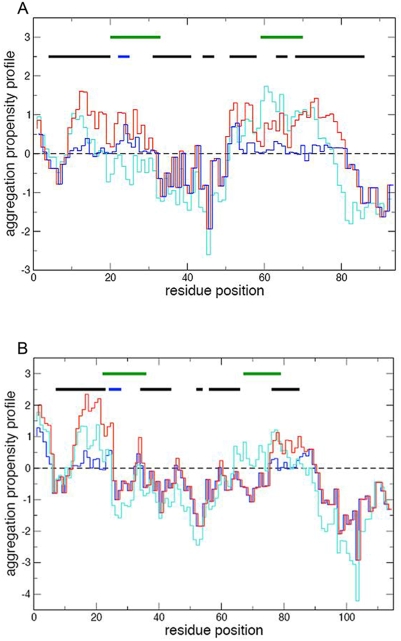
Intrinsic aggregation propensity profiles.(A) S100A8 and (B) S100A9 aggregation propensity profiles denoted at pH 7.0 by red, at pH 2.0 – by turquoise and in the natively folded S100A8/A9 complex – by blue lines, respectively. Calcium-binding sites are indicated by green, α-helices – by black and β-strands – by blue bars, respectively.